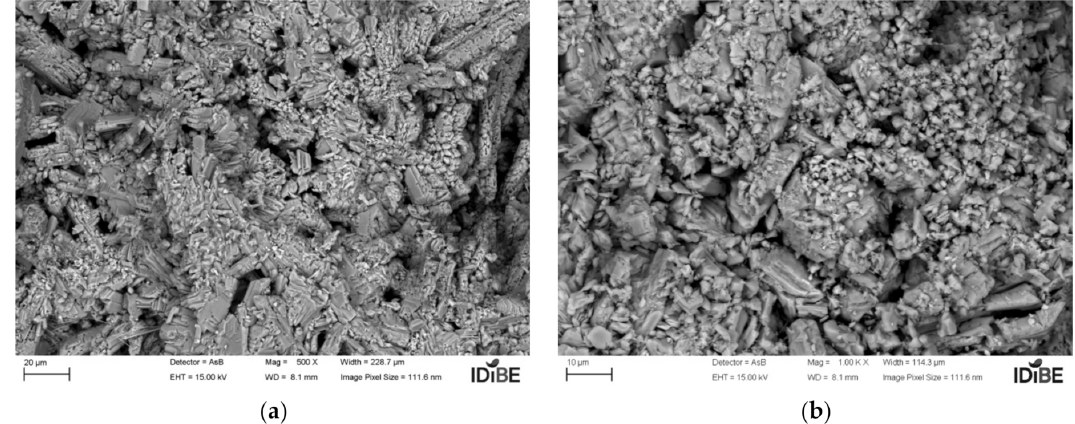
Figure 13. Micrograph of the 0.6% polycarboxylate compound (lot VS2): ( a ) 20 µ m; ( b ) 10 µ m (source: the author).